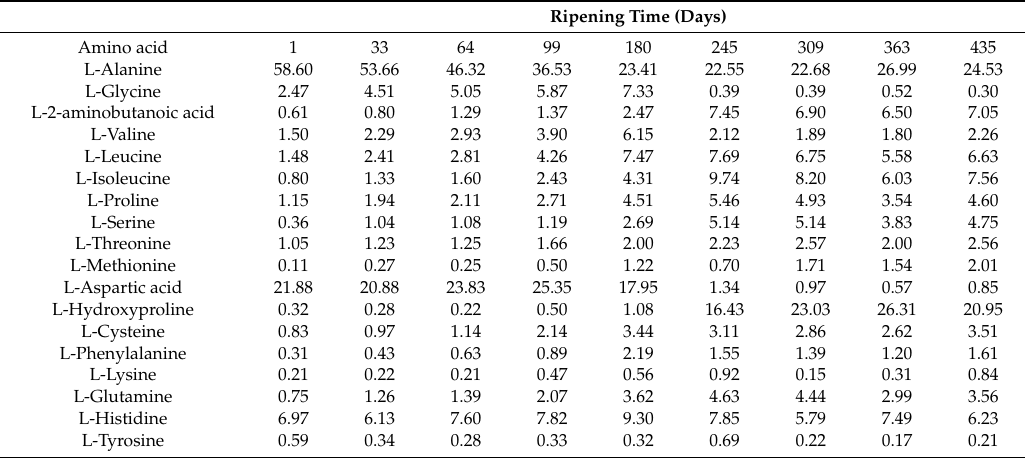
Ripening Time (Days)